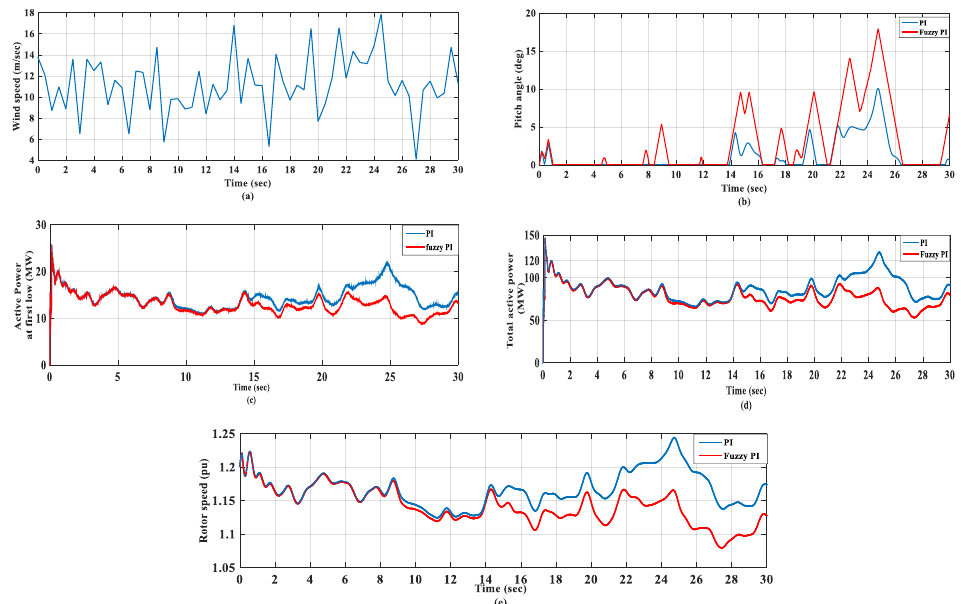
Figure 12. System response during random wind speed: ( a ) wind speed, ( b ) pitch angle, ( c ) active power of first row, ( d ) total active power, ( e ) rotor speed. power of first row, ( d ) total active power, ( e ) rotor speed.